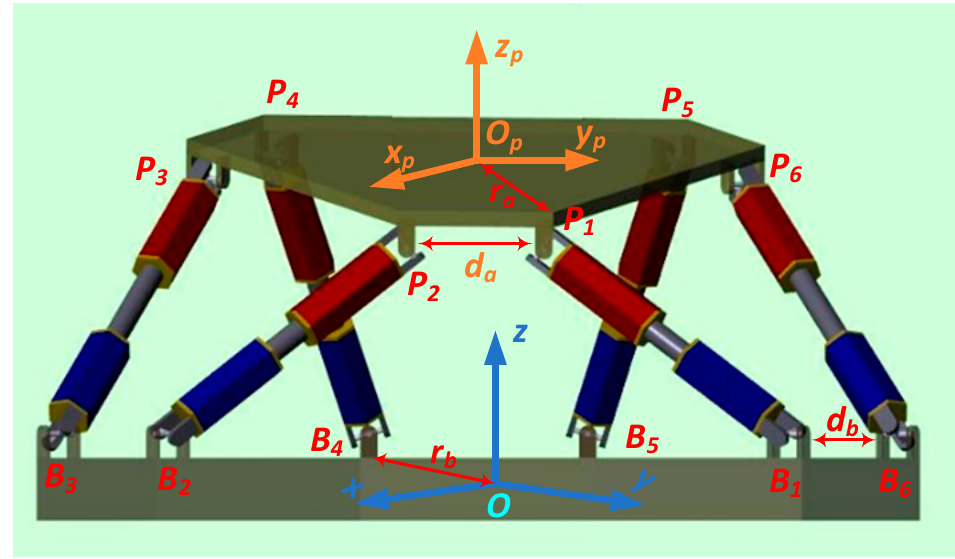
Figure 1. Structure of the Stewart platform.